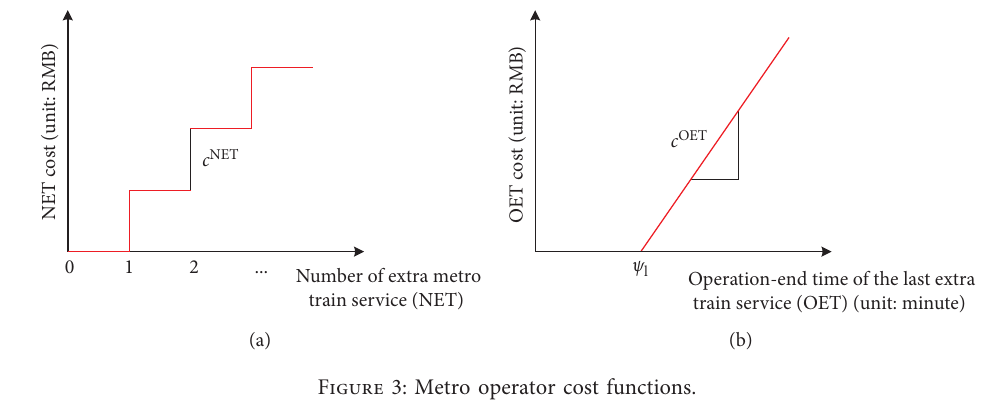
Figure 3: Metro operator cost functions.